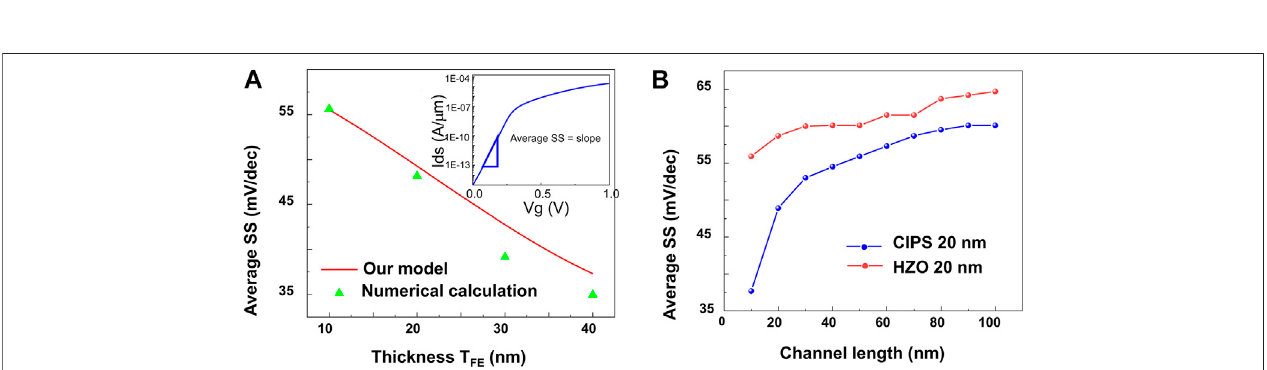
FIGURE3| Averagesubthresholdswingresultsandcomparisons.TheaverageSSisde fi nedanddeterminedbyextractingtheslopeoftransfercharacteristicover the whole subthreshold region in this work. (A) Average SS of the NC2D FETs with varying ferroelectric layer thickness. The red line is our established model, and the green dots are the numerical calculations of previous works. (B) Average SS along with channel length scaling with 20 nm CIPS and 20 nm HZO incorporation.